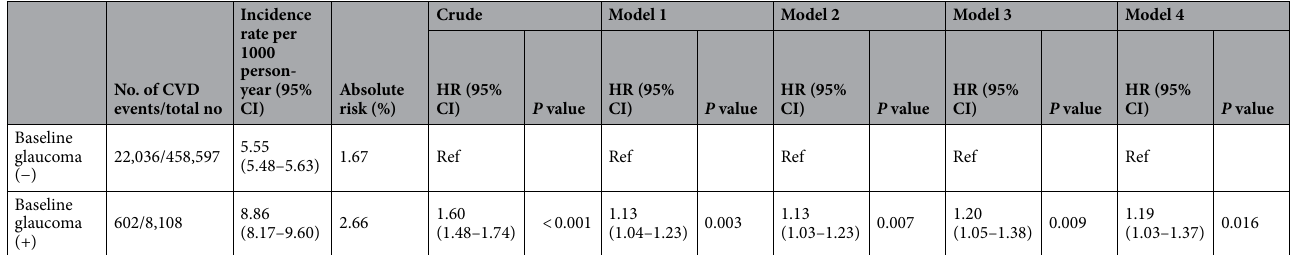
Table 2. Hazard ratios and 95% confidential intervals for cardiovascular disease using Cox proportional regression model. Model 1: Age + Sex + Race. Model 2: Model 1 + Familial history of heart disease + Familial